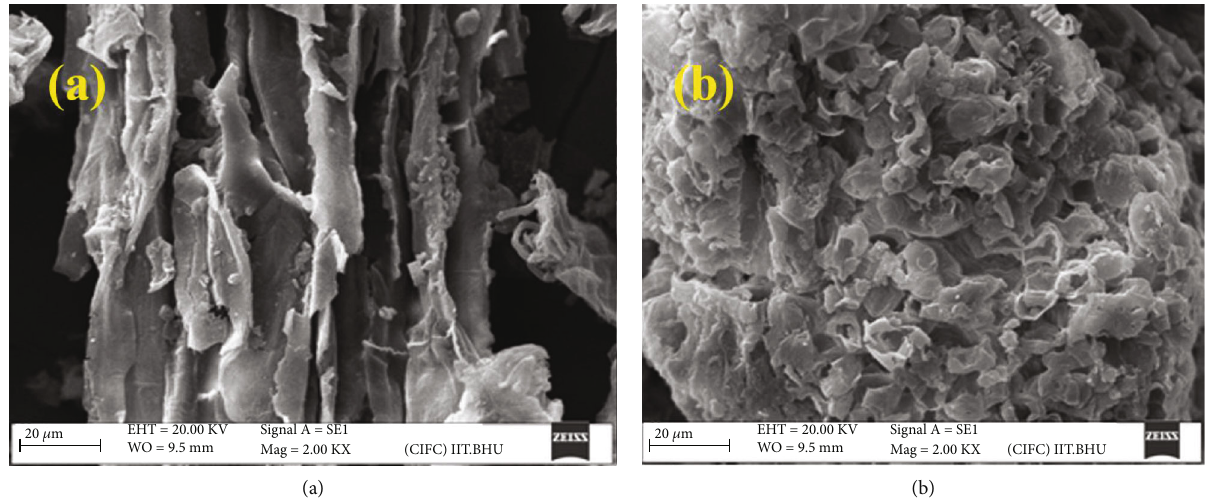
Figure 1: SEM image of Neolamarckia cadamba : (a) unloaded; (b) loaded with methylene blue.